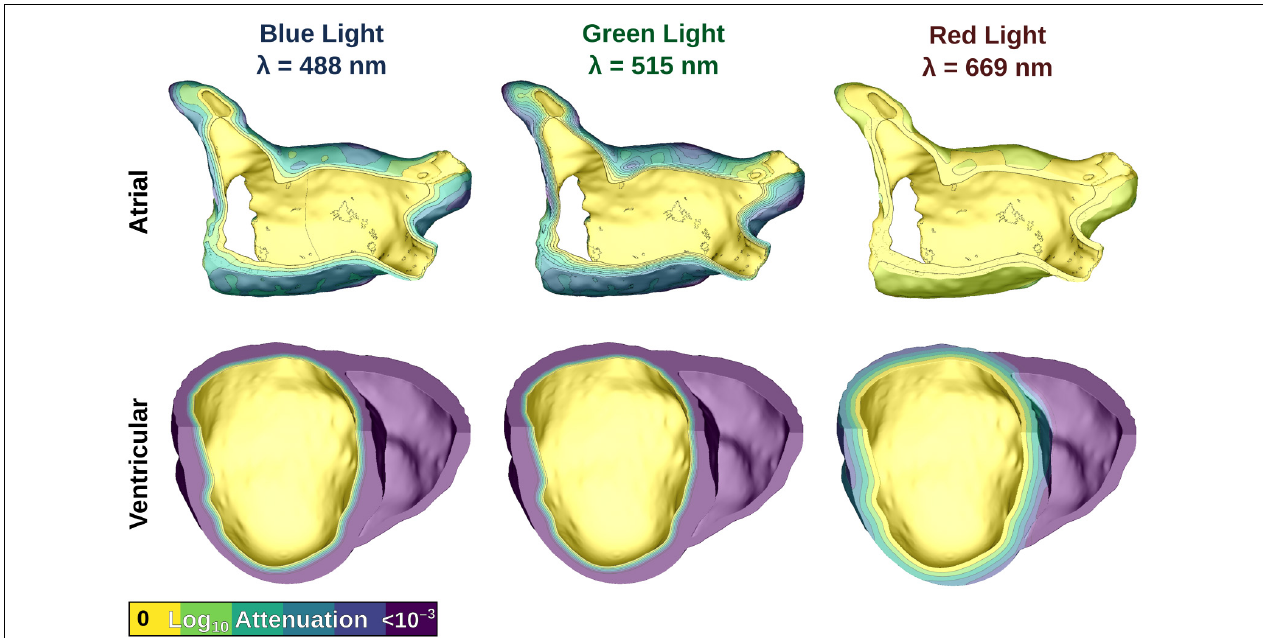
FIGURE 3 | Modeling illumination of atrial (top) and ventricular (bottom) models with light of different wavelengths. Attenuation color scale is shown on a log10 scale. Please note that despite the similarity of the first two panels in the bottom row, these are in fact distinct attenuation patterns for blue and green light.